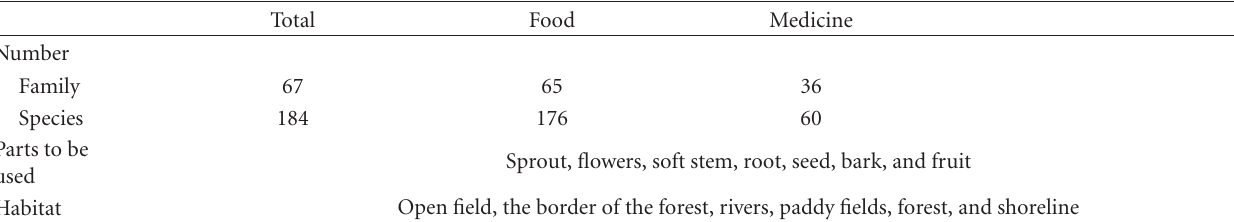
Table 2: The number of species of wild plants used as food and